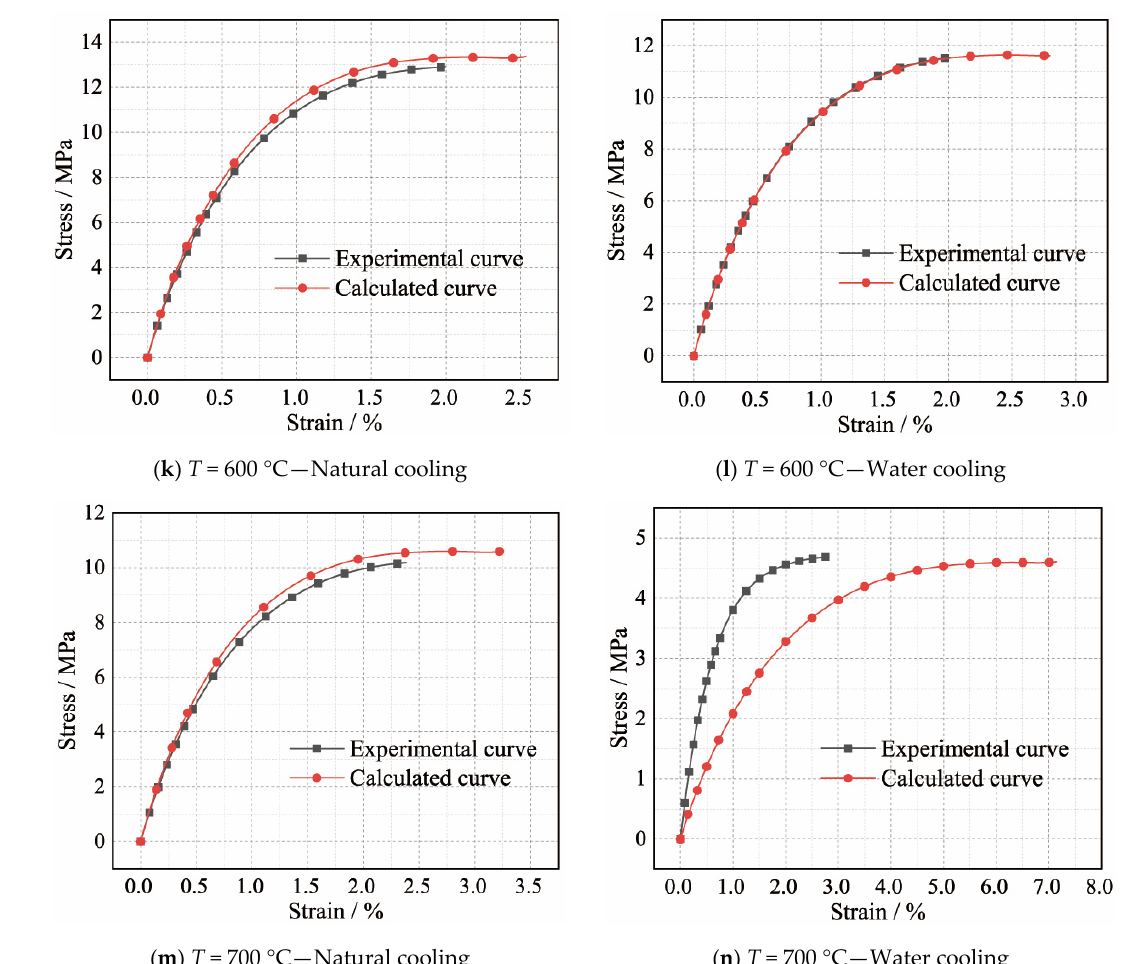
Figure 12. The comparison between experimental and calculated stress–strain curves of the fire- affected SCC.